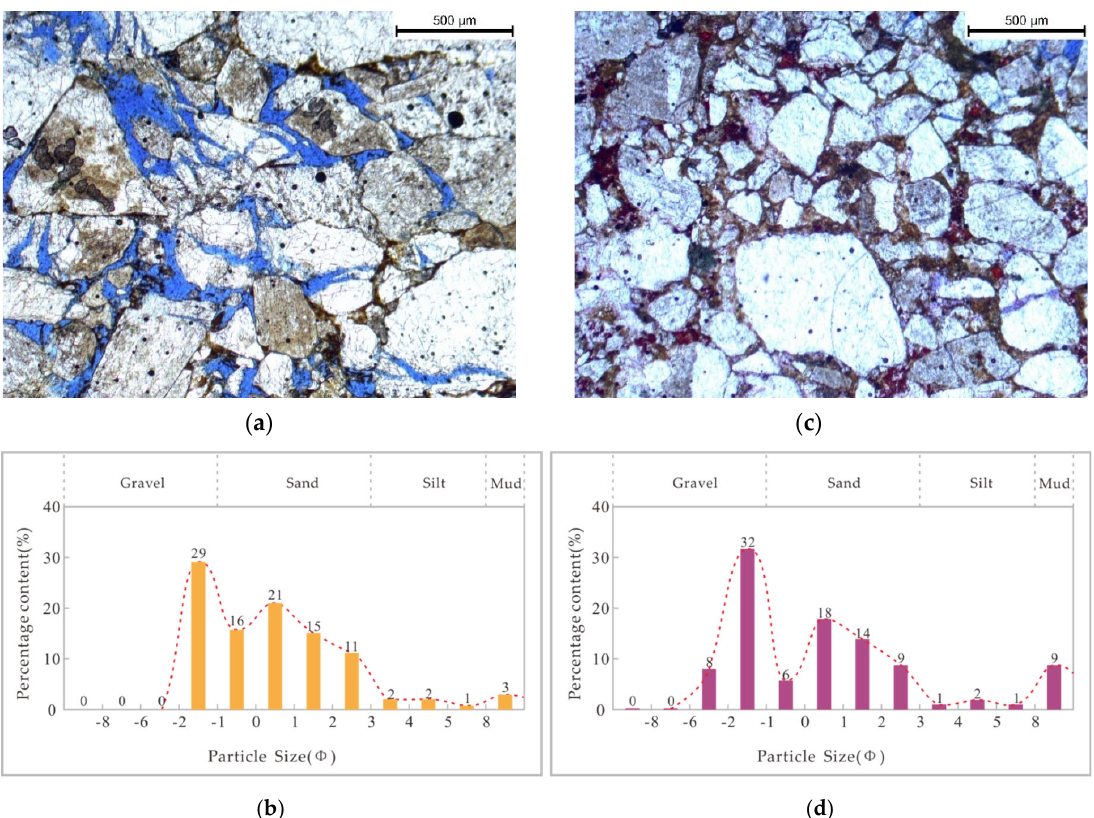
Figure 4. A chart of the reservoir structure model for the Qie12 block: ( a ) Well Qie12 − 10 − 8, 1858.06 m, gravel-bearing medium-coarse feldspar sandstone, primary intergranular pores; ( b ) Well Qie12 − 10 − 8, 1858.06 m, histogram of particle size distribution; ( c ) Well Qie12 − 10 − 8, 1859.4 m, argillaceous sandy conglomerate, dissolution pores, and argillaceous pores are the main pore types, rarely with visible pores; and ( d ) Well Qie12 − 10 − 8, 1859.4 m, histogram of particle size distribution.